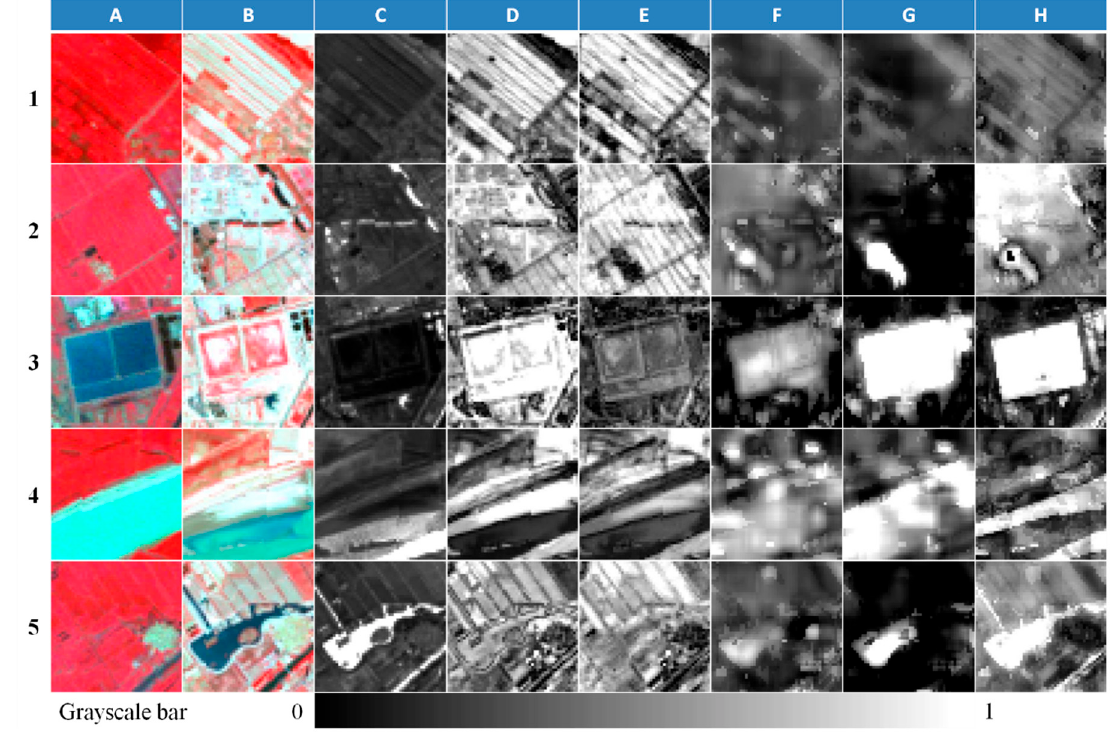
Figure 4. The change magnitude images of land cover conversions from 2010 (column A) to 2015 (column B) with Landsat images as a visual reference, where rows from 1 to 5 are the conversions of crop to crop, crop to built-up, water to vegetation, muddy water to bare land, and crop to water, respectively Columns C to H are the results of IR, CVA, SGD, NDVI-GD, Dcanb, and MSP, respectively.